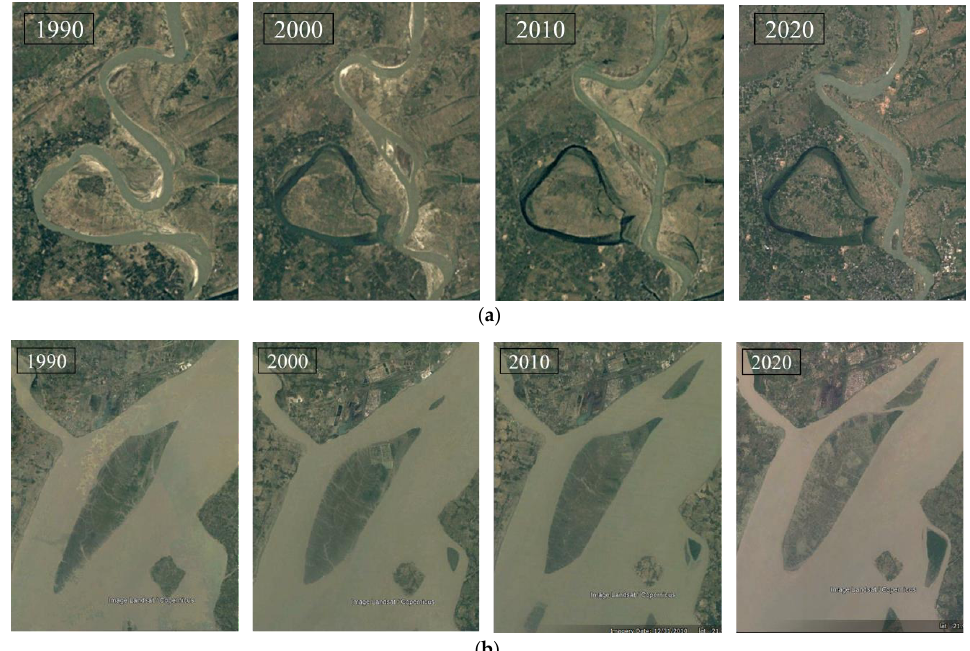
Figure A1. ( a ) A section in the upper-middle stretch of the Hugli River (along Purbastahli village) depicting drastic evolution of fluvial geomorphic features between 1990 and 2020. (Source: Google Earth). ( b ) Formation of bars and expansion of estuarine islands (Nayachars) in the Eastern section in the Hugli estuary between 1990 and 2020. (Source: Google Earth).